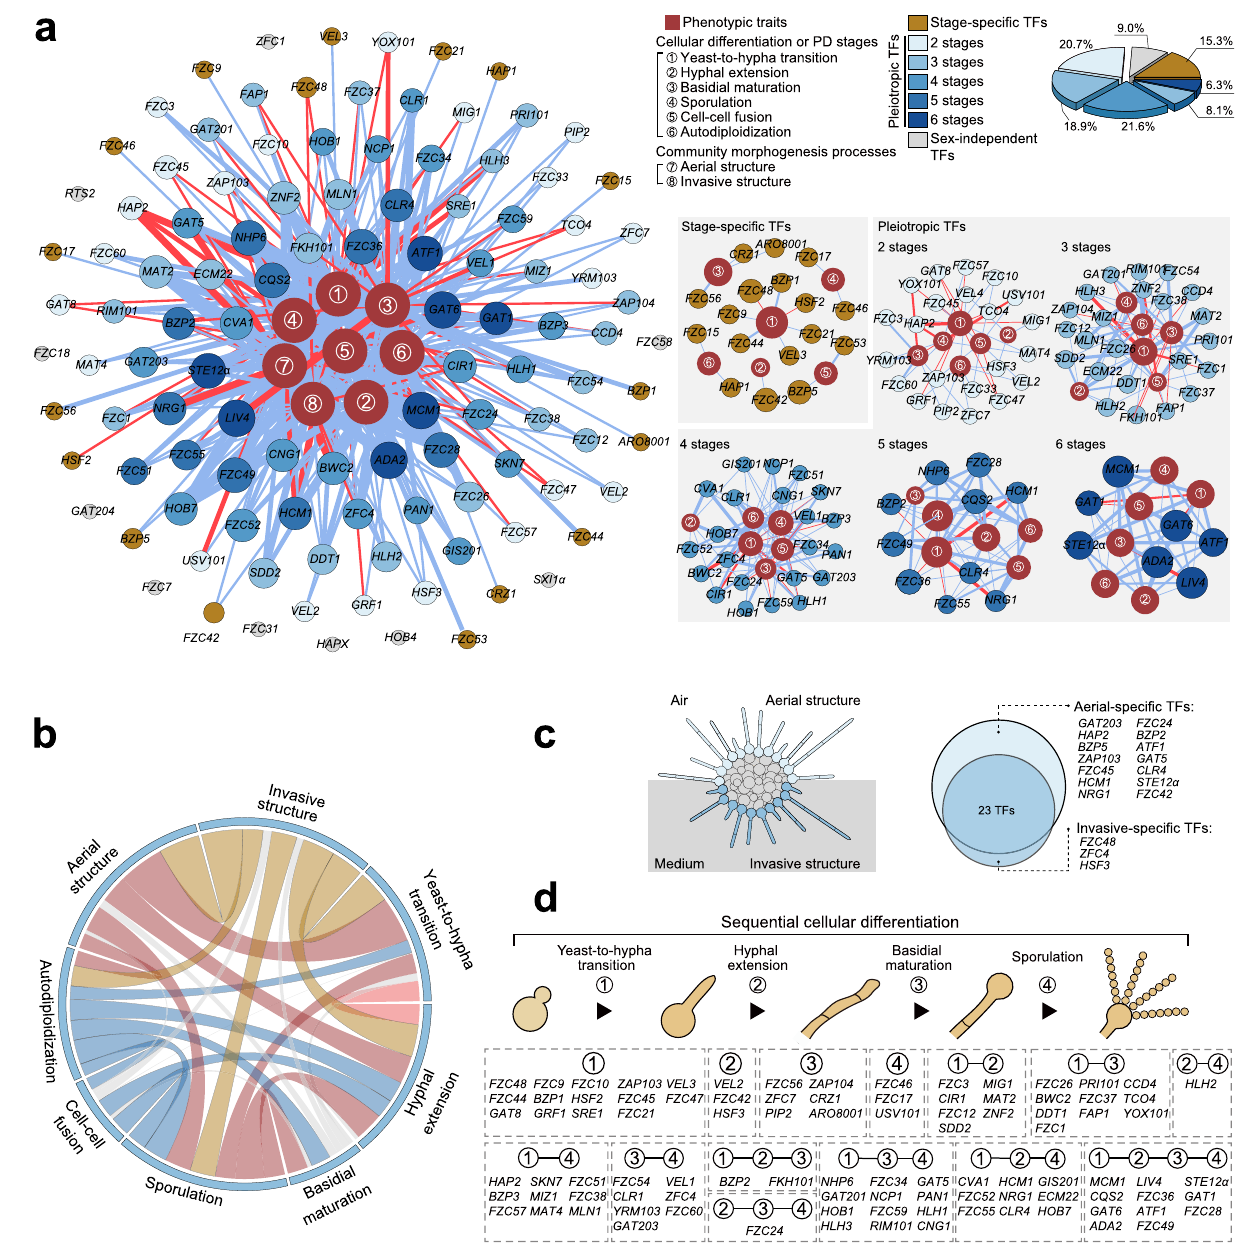
Fig. 2 | Spatiotemporal functional TF networks underlying sequential stages during sexual community development. a The bipartite network shows asso- ciations between TFs and eight phenotypic traits. Red nodes indicate the eight phenotypic traits, and other nodes represent TFs. Nodes are sized according to their respective degree of connectivity, with bigger nodes indicating higher con- nectivity. The edges represent the regulation strength (strong, intermediate and weak) of TFs on phenotypic traits, and red and blue edges indicate positive and negative regulations,respectively.Agradientcolor(from lightblue todarkblue)is used to indicate the number of phenotypic traits (1 to 6 stages) regulated by a TF.